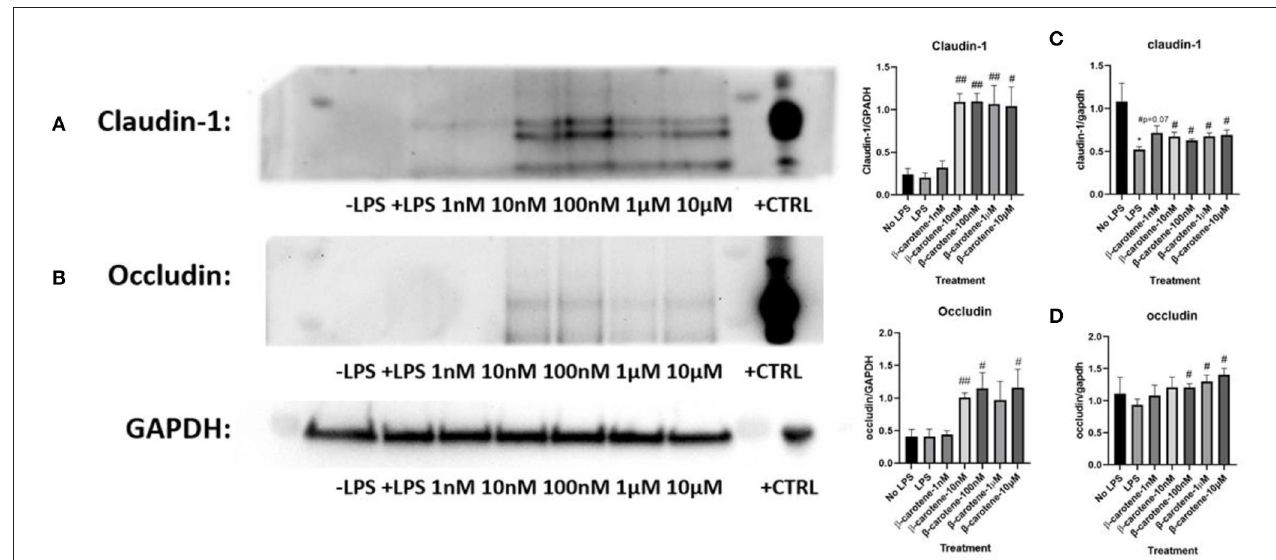
FIGURE 2 | β -Carotene treatments induce tight junction proteins. (A,B) Western blot membranes with tight junction protein expression of (A) claudin-1 and (B) occludin. Positive control ( + CTRL), obtained from A431 cells. (C,D) Fold changes in mRNA levels of (C) claudin-1 and (D) occludin generated from qPCR. Five treatment doses of β -carotene (1, 10, 100nM, 1, 10 µ M). Four replicates used for statistical analysis of western blot and qPCR. Values are means ± SEMs. *significance at p < 0.05 for comparison with the “No LPS” group. # significance at p < 0.05 for comparison with the “LPS” group, ## significance at p < 0.01 for comparison with the “LPS”